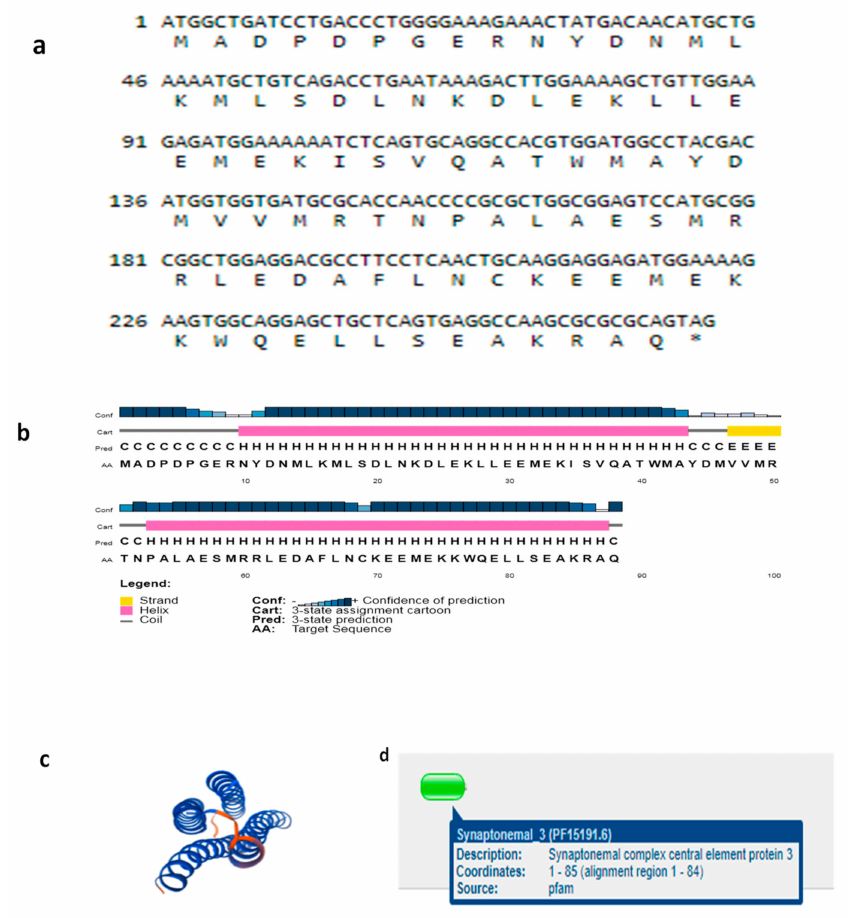
Figure 3. Exploration of the protein sequence encoded by TSEG2 from Datong yak. The protein encoded by Datong Yak TSEG2 contains a synaptonemal complex central element 3. ( a ) The sequences of yak TSEG2 genes and predicted protein. ( b ) Estimated secondary structure for the protein encoded by TSEG2 has a long vertical bar, short vertical bar, coil a-helix; sub medium vertical bar b turn, medium vertical bar extended strand ( c ) predicted conserved domain for the protein encoded by TSEG2. ( d ) Estimated three-dimensional structures of the protein encoded by